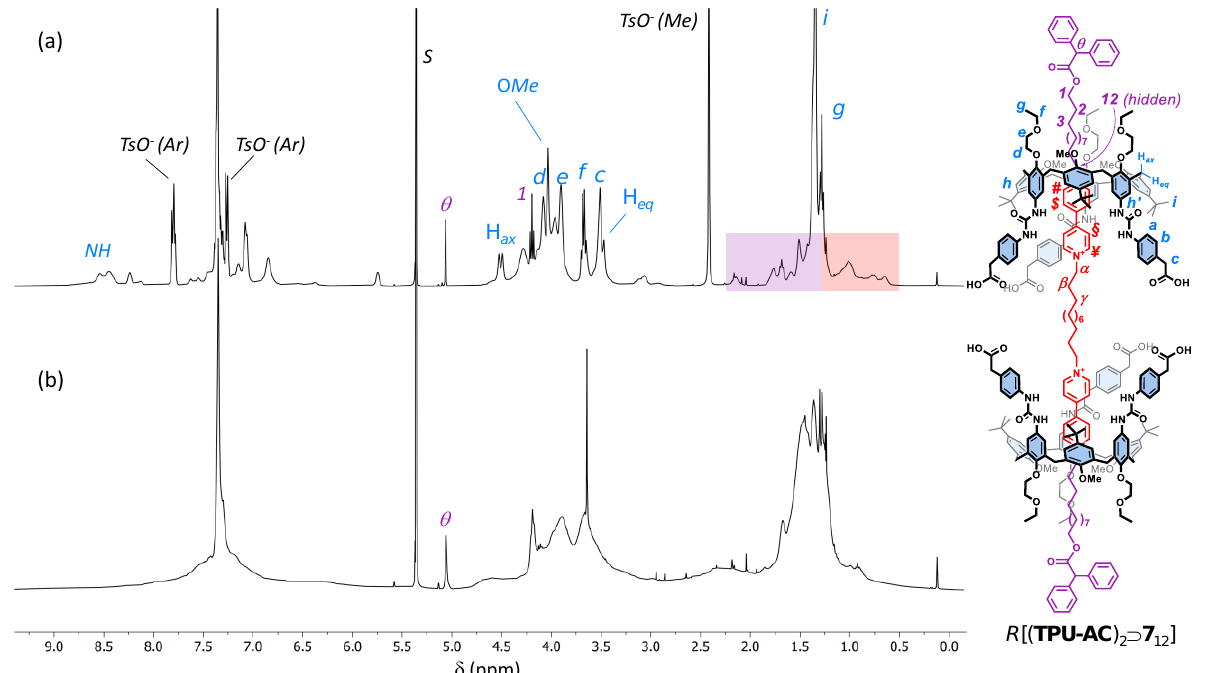
Figure 5. 1 H NMR spectra (400 MHz) of R [( TPU-AC ) 2 ⊃ 7 12 ] in CD 2 Cl 2 before ( a ) and after ( b ) the treatment of the solution with 4 eq. of TsOH∙H 2 O. The purple and orange boxes in ( a ) highlight the upfield-shifted resonances of the external and internal alkyl chains of the complexed dumbbell ( 7 12 ), respectively (see the sketch on the right for protons labels; the tosylates have been omitted for more clarity).